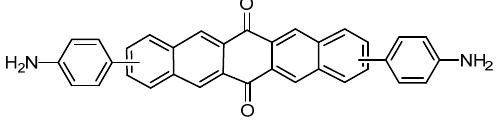
Figure 3. Pentacenequinone derivative.